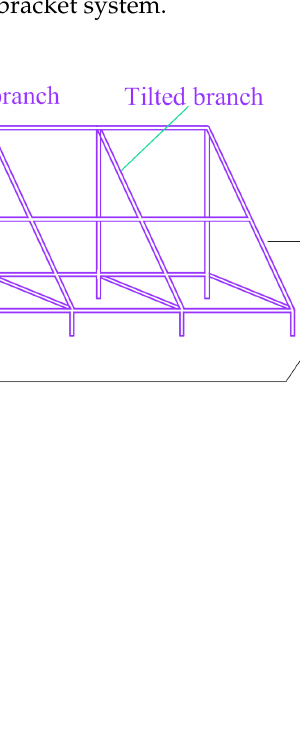
Figure 2. Circuit model of PV bracket